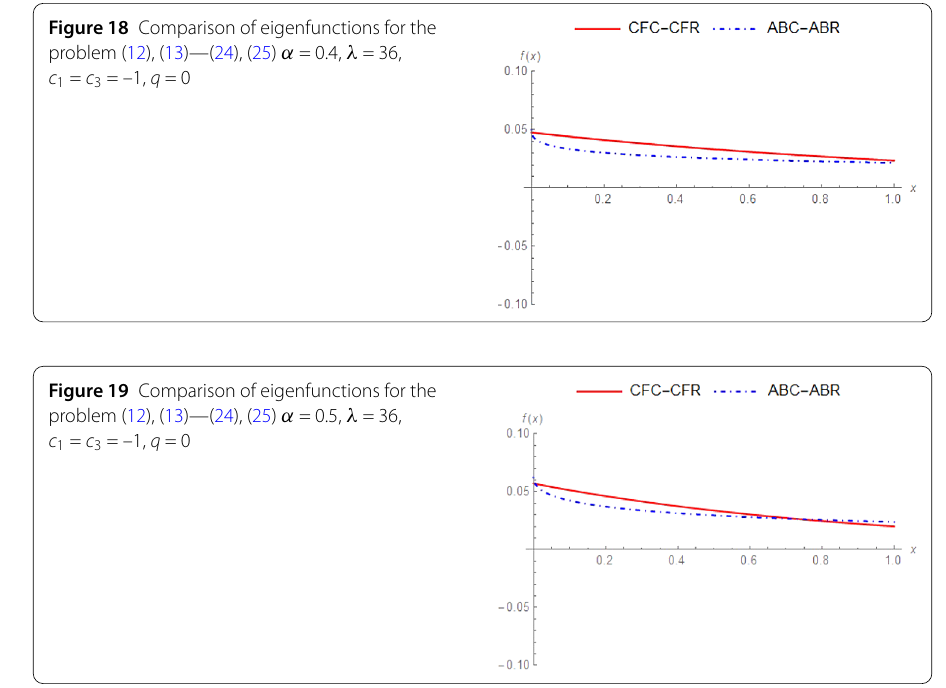
Figure 18 Comparison of eigenfunctions for the problem (12), (13)—(24), (25) α = 0.4, λ = 36, c 1 = c 3 = –1, q = 0